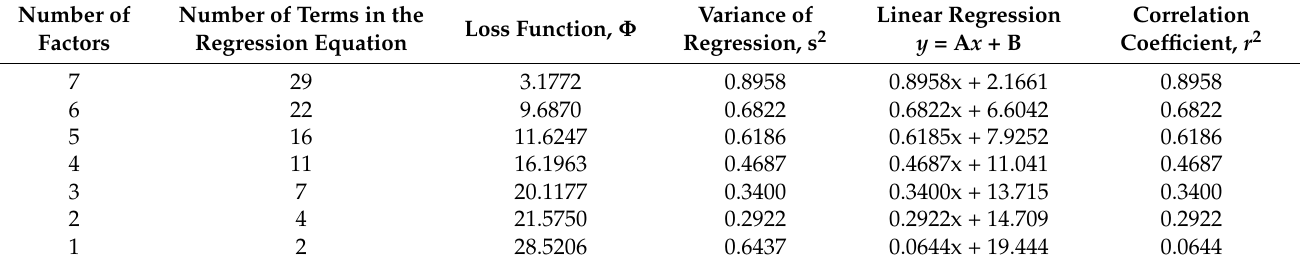
Table 5. Best-fitting parameters of the linear regression line. The results were calculated based on various numbers of risk factors via the STATISTICA 7.0 program. In addition, the original predictions according to seven risk factors are also listed for